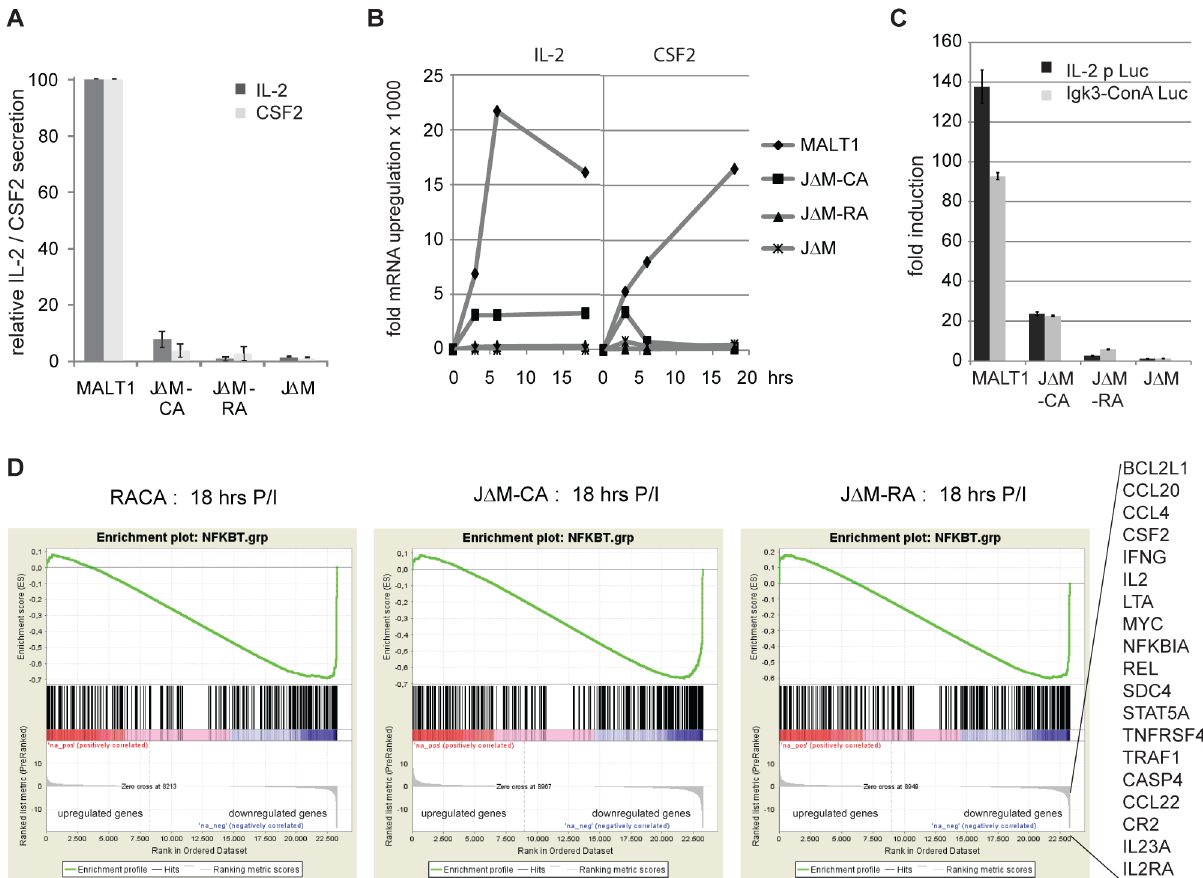
Figure 7. MALT1 auto-proteolysis is required for NF- k B transcriptional activity in Jurkat T cells. A) Relative IL-2 and CSF2 production of indicated Jurkat T cell lines, stimulated for 18 hrs with PMA/ionomycin, measured via ELISA. Data shown as mean + /- S.D. (n=3). B) Jurkat T cells expressing MALT1 and the J D M-CA, J D M-RA, and J D M cells were stimulated for the indicated times with P/I and IL-2 and CSF2 transcript levels were determined via qRT-PCR. C) Jurkat T cells with ectopic expression of MALT1 and J D M-CA, J D M-RA and J D M were electroporated (Amaxa, Nucleofection) with Luciferase reporter constructs driven by the IL-2 promoter or the Ig k 3-ConA promoter, and 24 hrs later stimulated with P/I for 18 hrs before Luciferase activity was measured. Data shown as mean + /- S.D. (n=3). D) GSEA showing a significant enrichment of NF- k B-target genes (FDR q , 0,001) in the pre-ranked down-regulated genes from J D M-CA, J D M-RA and RACA cells stimulated for 18 hrs with P/I. Gene list depicted at the right side are NF- k B target genes down-regulated in J D M-CA, J D M-RA and RACA cells after 3 and 18 hrs stimulation with